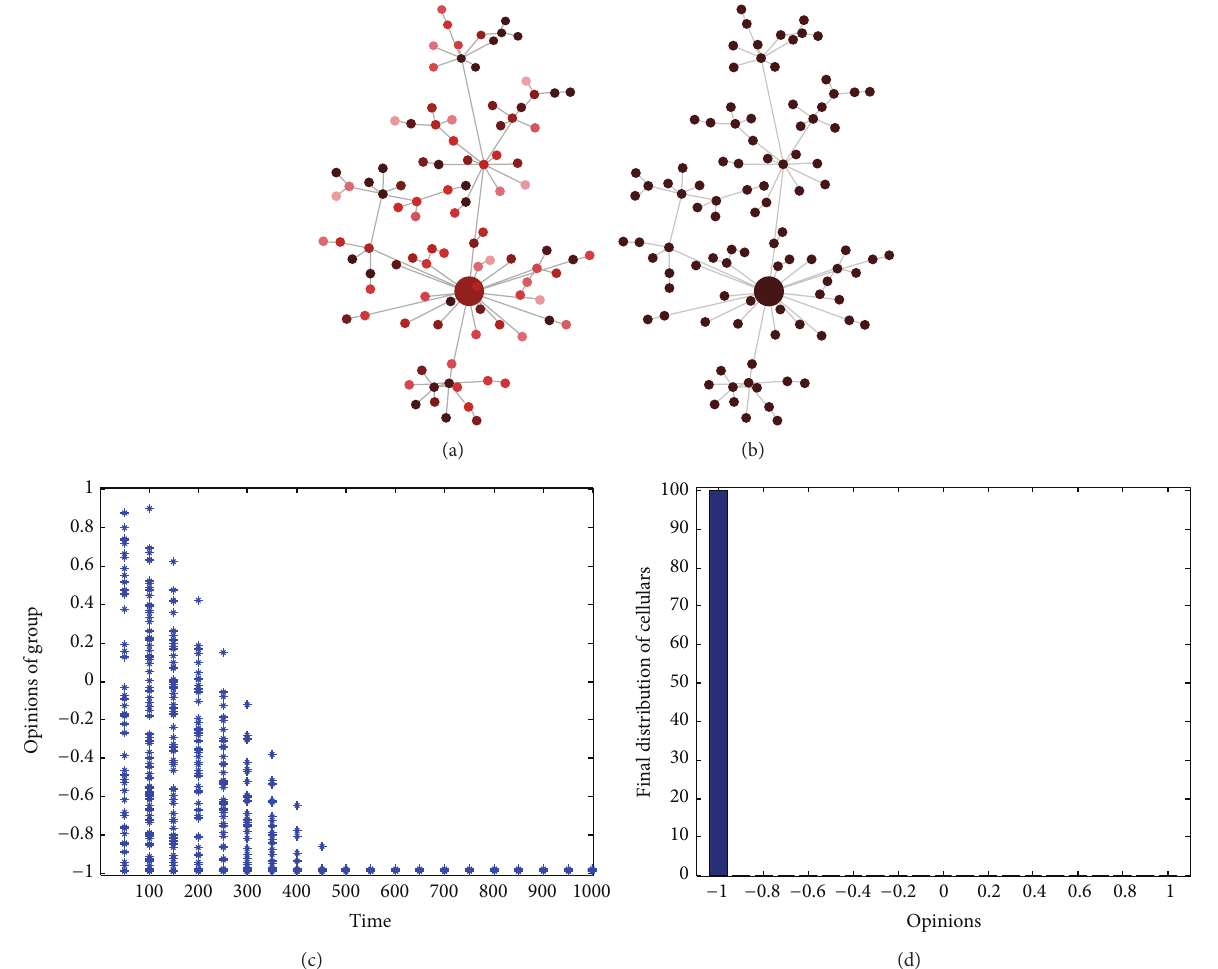
Figure 11: When 𝑎 = 0.7 , 𝑏 = 0.3 , and 𝑐 = 0 , opinion leader influences the polarization of Internet group opinions. (a) Opinions distribution at 100 time steps; the opinion of opinion leader is − 0.45 now. (b) Opinions distribution at 1000 time steps; the opinion of opinion leader changes to − 1. (c) Opinions of group change with times. (d) Histogram of final distribution of group